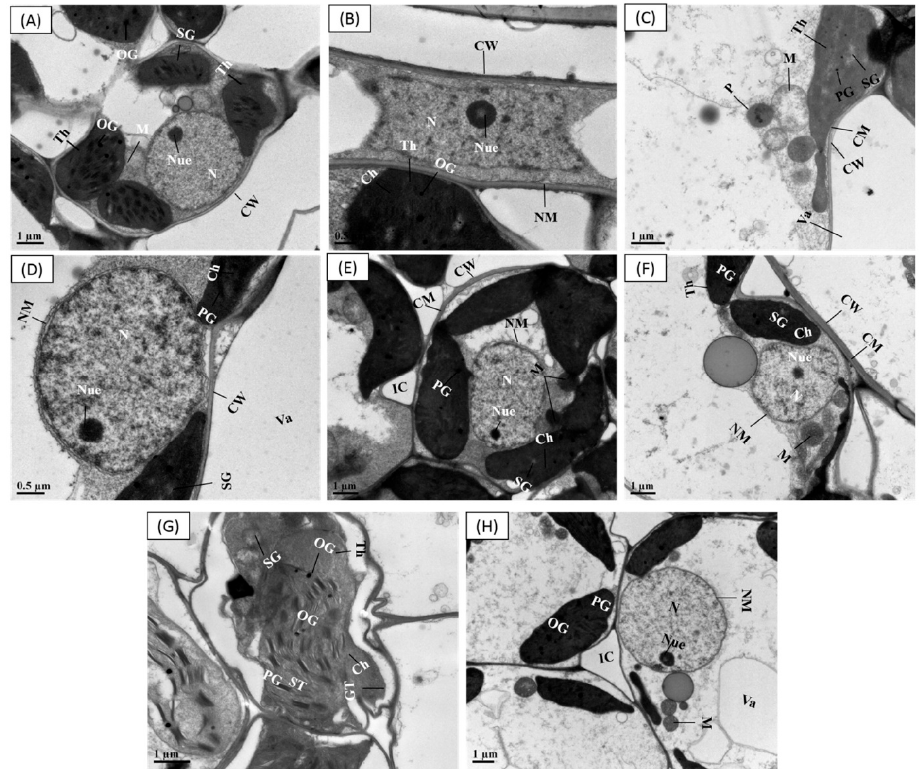
Figure 6. Effect of seeds primed with SPM on cellular ultra-structural changes in the leaves of two different rice cultivars (CY927 and YLY689) against chromium (Cr). ( A ) Leaf mesophyll cell of CY927 (primed with water) at control level, ( B ) Leaf mesophyll cell of CY927 (primed with Spm) at control level, ( C ) Leaf mesophyll cell of CY927 (primed with water) under Cr stress, ( D ) Leaf mesophyll cell of CY927 (primed with Spm) under Cr toxicity, ( E ) Leaf mesophyll cell of YLY689 (primed with water) at control level, ( F ) Leaf mesophyll cell of YLY689 (primed with Spm) at control level, ( G ) Leaf mesophyll cell of YLY689 (primed with water) under Cr stress, ( H ) Leaf mesophyll cell of YLY689 (primed with Spm) under Cr toxicity. Abbreviations: N (nucleus), SG (starch grain), NM (nuclear membrane), PG (plastogloboli), CW (cell wall), Va (vacuole), Ch (chloroplast), CM (cell membrane), (chloroplast), GT (granule thylakoids); M (mitochondria), ST (stomata thylakoids).